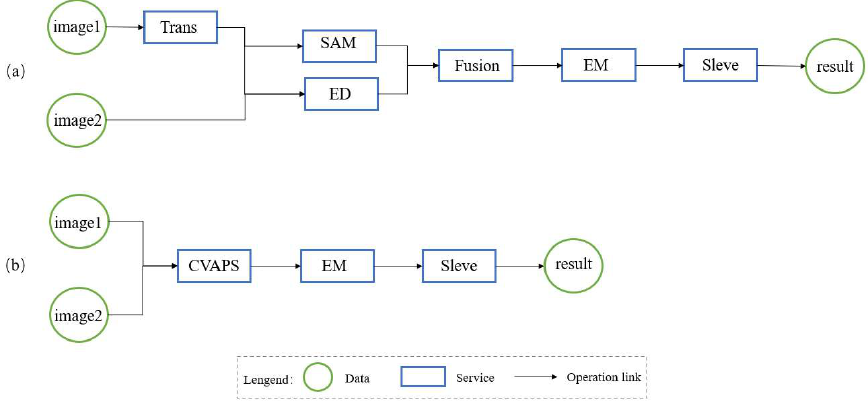
Figure 11. Two generated change detection service chains. ( a ) A service chain based on the constraint-aware GraphPlan algorithm; ( b ) A service chain bases on the traditional GraphPlan algorithm.